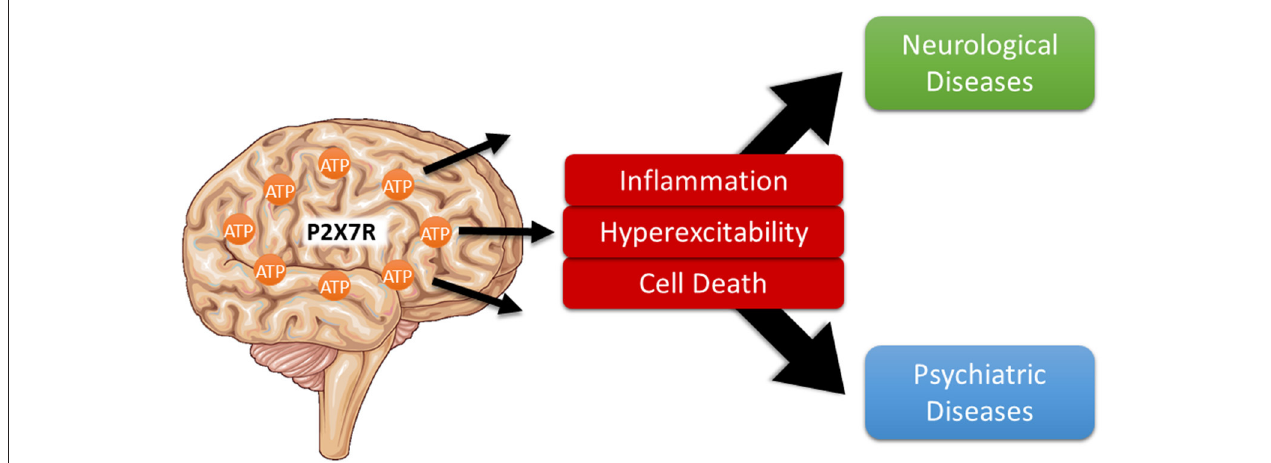
FIGURE 1 | P2X7 receptor activation as shared pathological pathway in brain diseases. Usually found at low extracellular concentrations, ATP levels strongly increase during noxious conditions in the brain. Once released, ATP activates specific purinergic receptors including the ionotropic P2X7 receptor which, in turn, contribute to multiple pathological processes shared among several neurological and psychiatric brain diseases including neuroinflammation, increased hyperexcitability, and neurodegeneration thereby driving disease